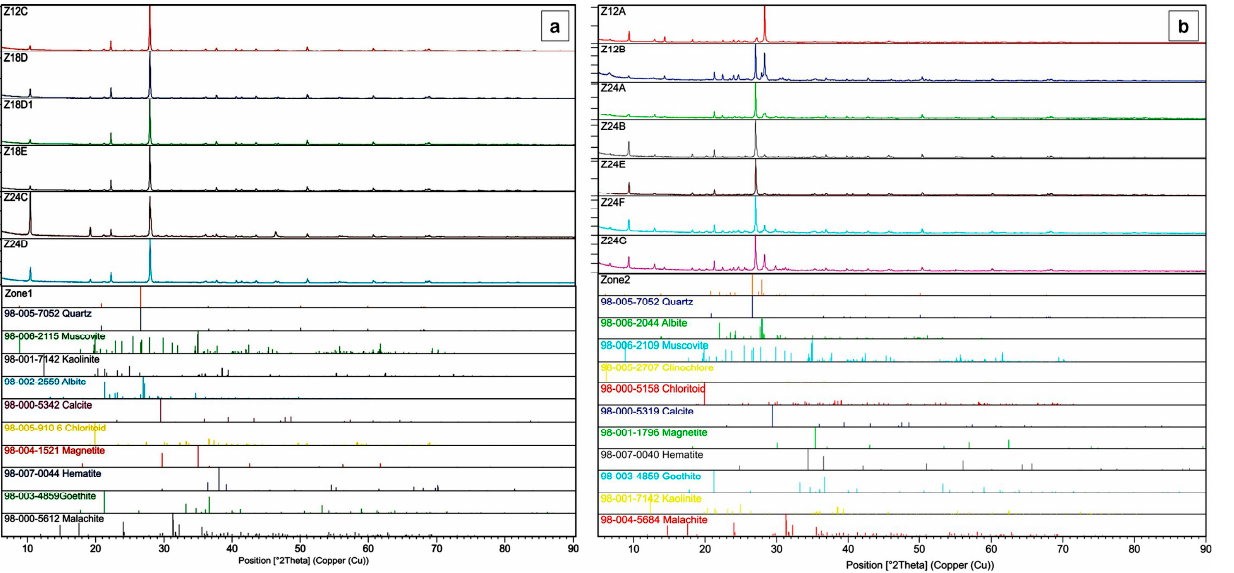
Figure 8. XRD patterns of some selected altered samples collected from the different alteration types: ( a ) Sericite-kaolinite-quartz-pyrite ± albite alteration zone-1. ( b ) Chlorite–calcite–dolomite ± albite ± sericite alteration zone-2.